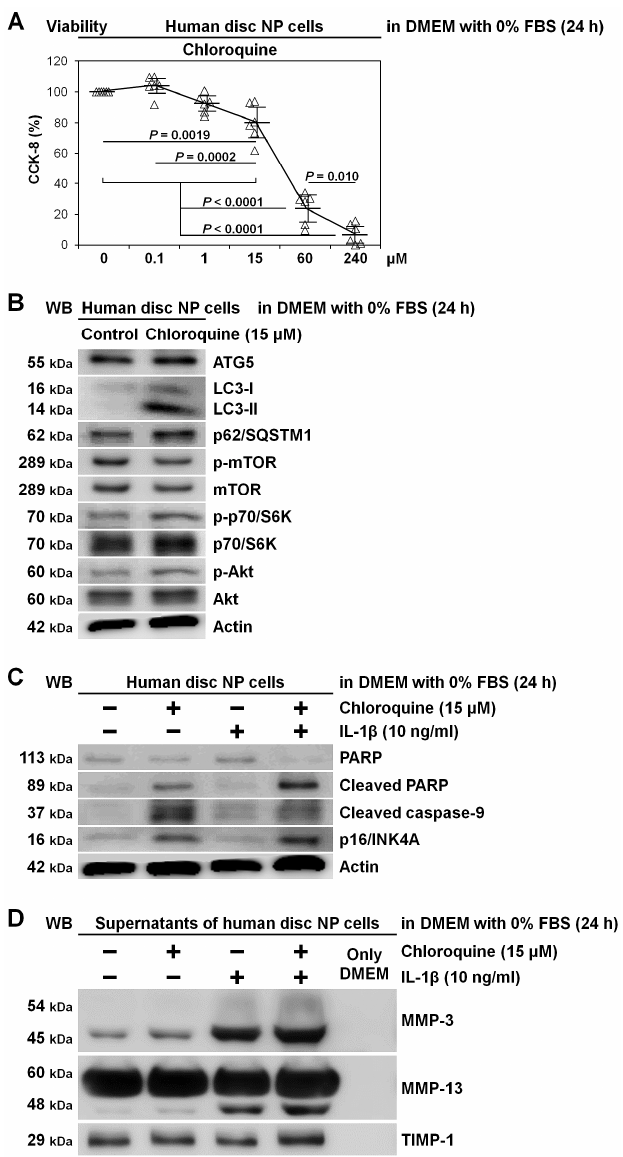
Figure 5. Induced apoptosis and senescence rather than matrix catabolism by autophagy inhibition through chloroquine supplementation in human disc NP cells. ( A ) Cell viability of human disc NP cells using CCK-8 after treatment of 0–240 µ M chloroquine in serum-free DMEM with 0% FBS for 24 h. Changes in CCK-8 dehydrogenase activity of chloroquine treatment relative to the vehicle control are shown. Data are the mean ± 95% CI. One-way repeated-measures ANOVA and the Tukey–Kramer post-hoc test were used ( n = 6). ( B ) Western blotting for autophagic ATG5, LC3, and p62/SQSTM1 and mTOR signaling-related mTOR, phosphorylated mTOR, p70/S6K, phosphorylated p70/S6K, Akt, and phosphorylated Akt in total protein extracts from human disc NP cells after culturing for 24 h in serum-free DMEM with or without 15 µ M chloroquine. Actin was used as a loading control. Immunoblots shown are representative of experiments with similar results ( n = 6). ( C ) Western blotting for pro-apoptotic cleaved PARP and cleaved caspase-9, anti-apoptotic PARP, pro-senescent p16/INK4A, and loading control actin in total protein extracts from human disc NP cells after culturing for 24 h in serum-free DMEM with or without 15 µ M chloroquine. Immunoblots shown are representative of experiments with similar results ( n = 6). ( D ) Western blotting for catabolic MMP-3 and MMP-13 and anti-catabolic TIMP-1 in supernatant protein extracts from human disc NP cells after 24 h culture in serum-free DMEM with or without 15 µ M chloroquine. Immunoblots shown are representative of experiments with similar results ( n =